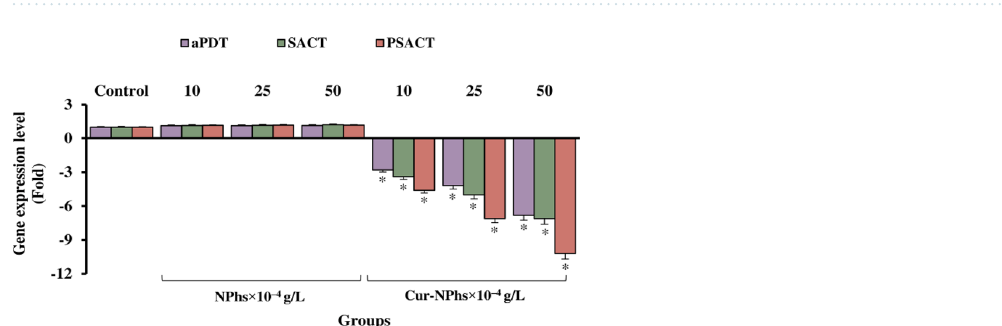
Figure 9. Gene expression levels of qseB and qseC following different treatments. Significant differences according to the control, *P < 0.05.